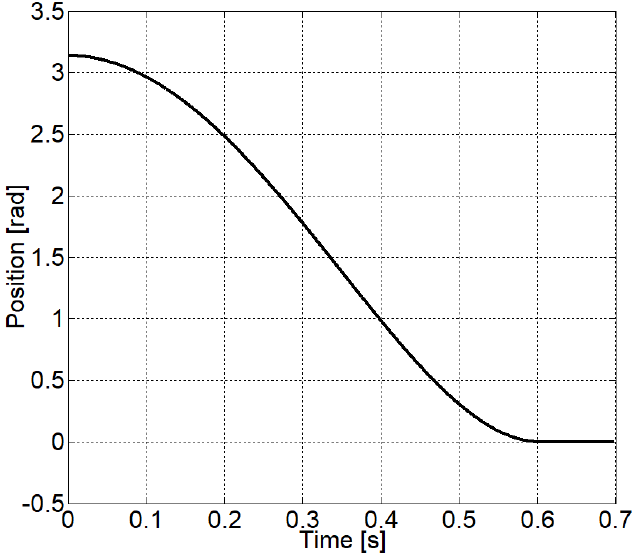
Figure 7. System’s position with the velocity constraint.